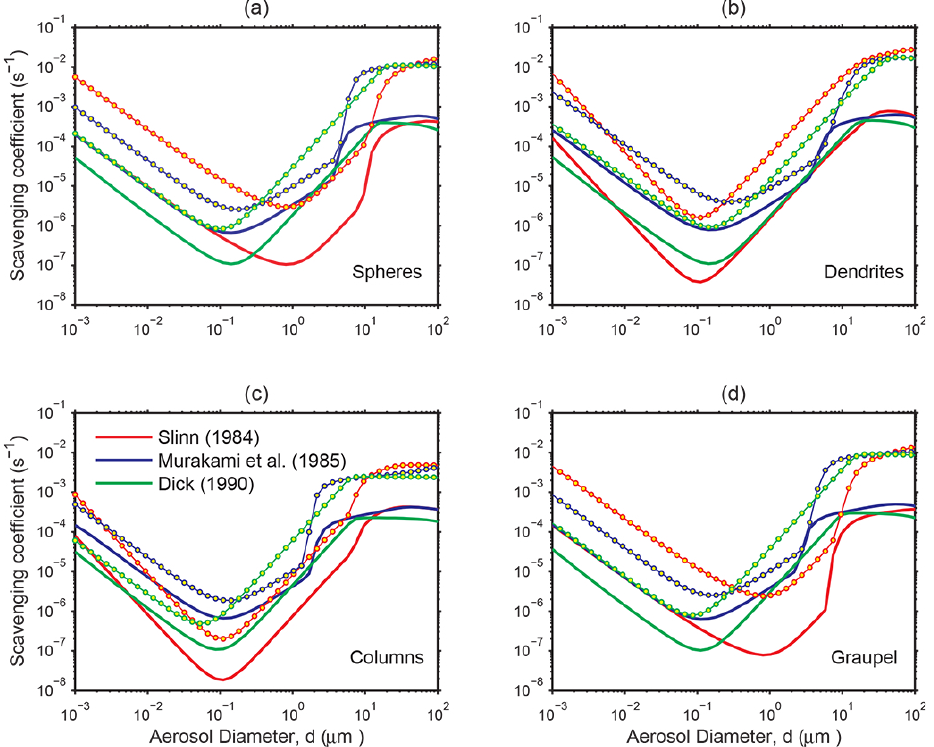
Fig. 2. Size-resolved snow scavenging coefficient profiles 3 snow determined for three different E(d p ,D p ) formulas (three different colours) under snowfall intensities of 0.1 (solid line) and 10.0mmh − 1 (symbol line) for four snow-particle shapes: (a) spheres; (b) dendrites; (c) columns; and (d)